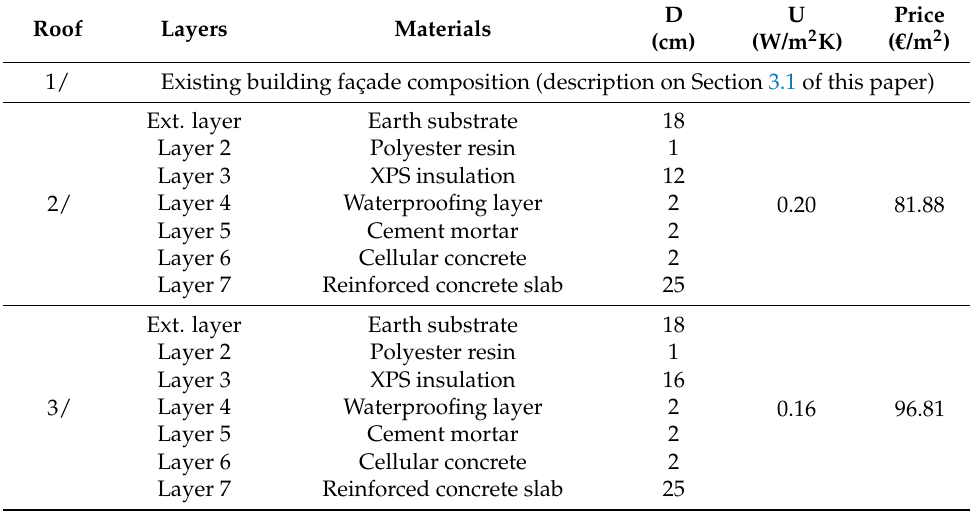
Table A4. Proposed renovation measures for roof